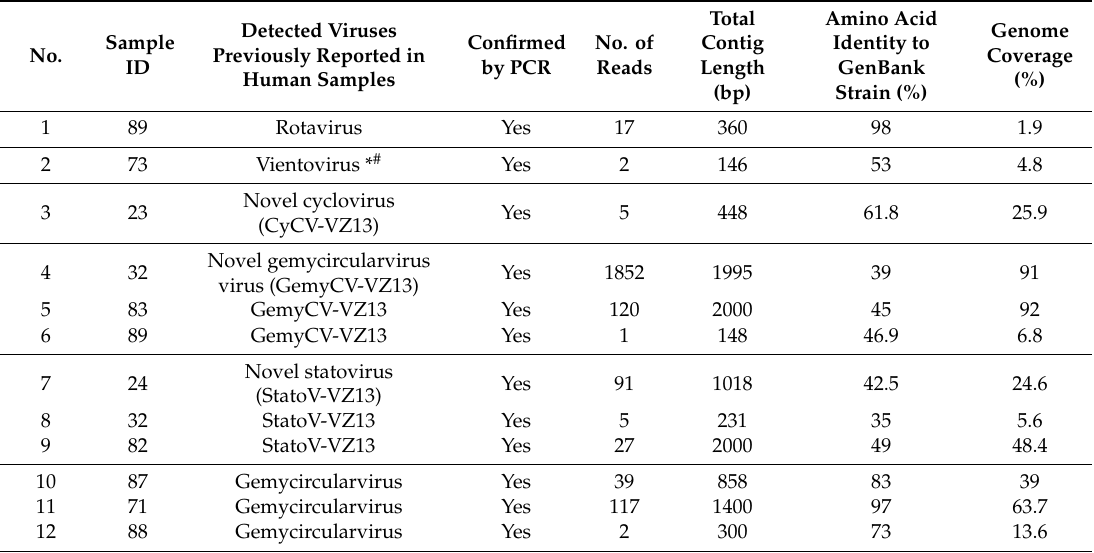
Table 3. Metagenomic detection of viruses that have previously been detected in human samples in nasal-throat swab samples negative for human viral pathogens by diagnostic RT-PCR [5].